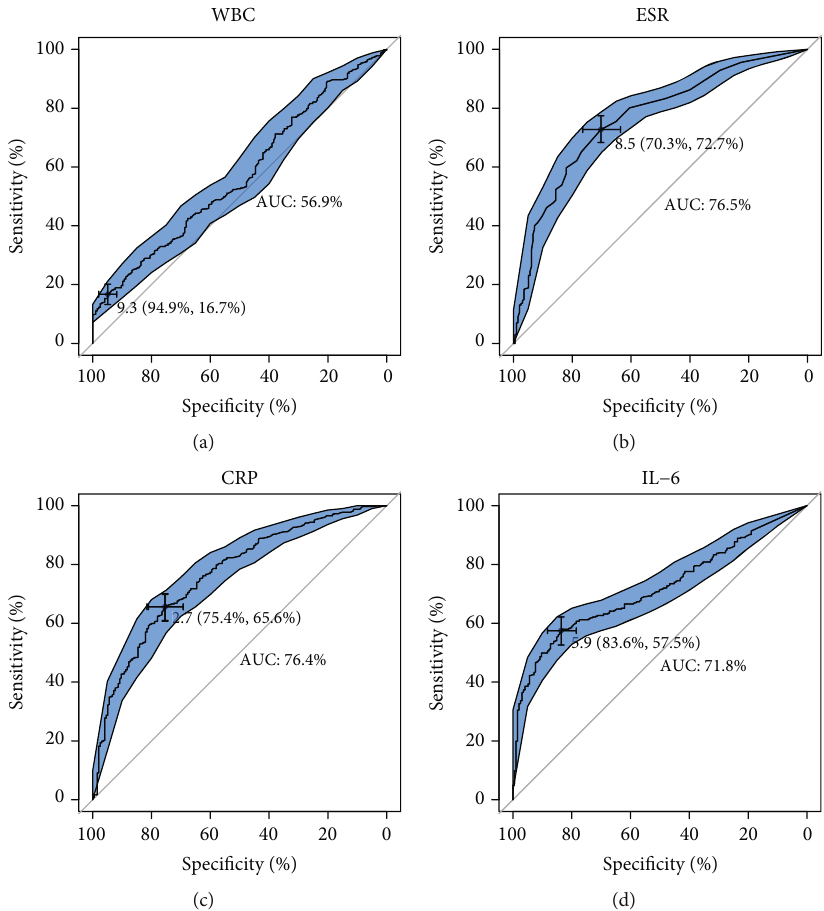
Figure 2: ROCs of the four in fl ammatory biomarkers for FRI diagnosis. The areas in deep blue represent 95% CIs of the AUCs. Table 4: Discriminatory strengths of the four in fl ammatory biomarkers. Infection